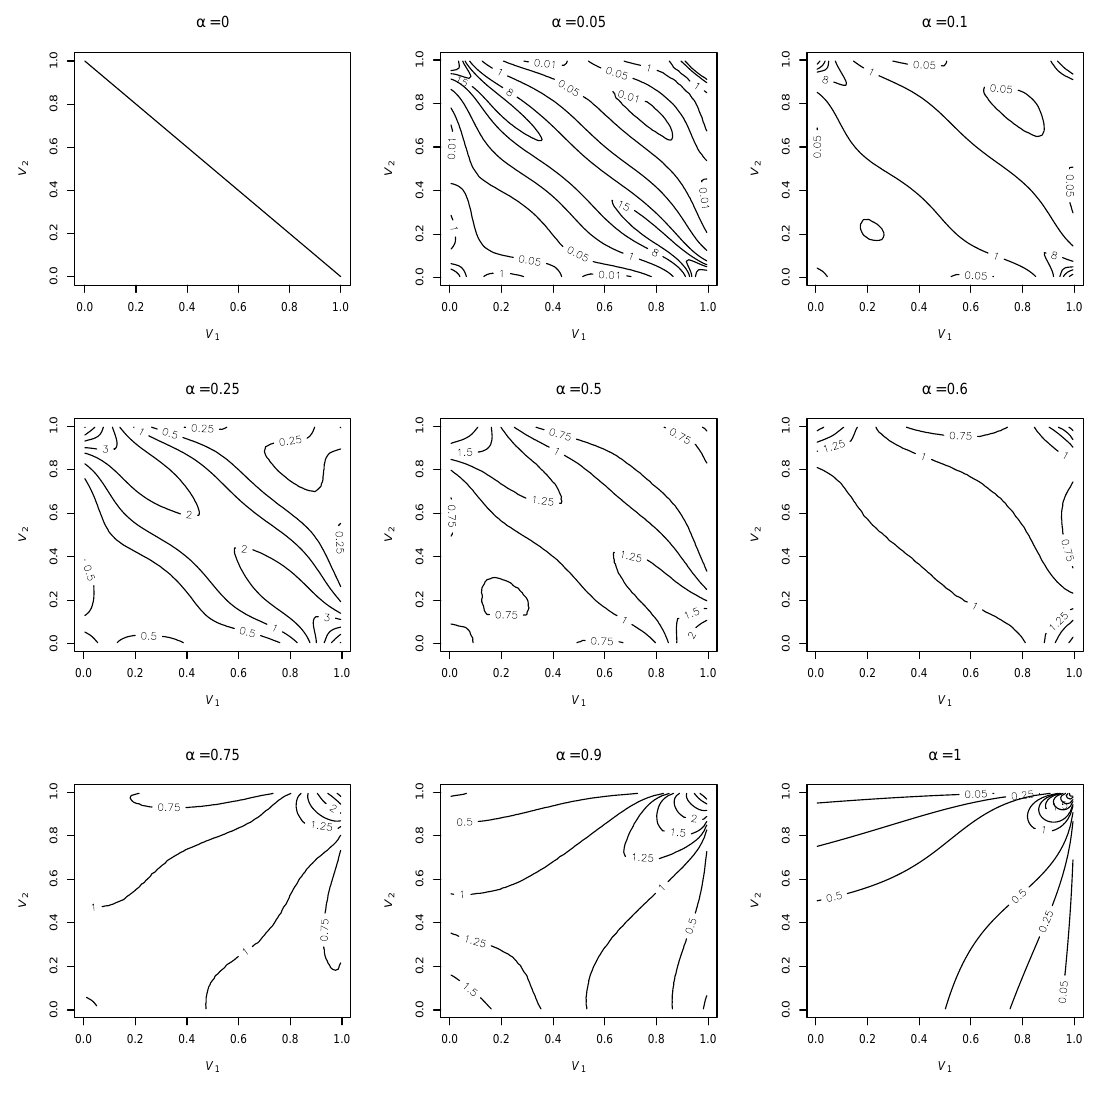
Figure 2: AN(5A) densities for various values of α .